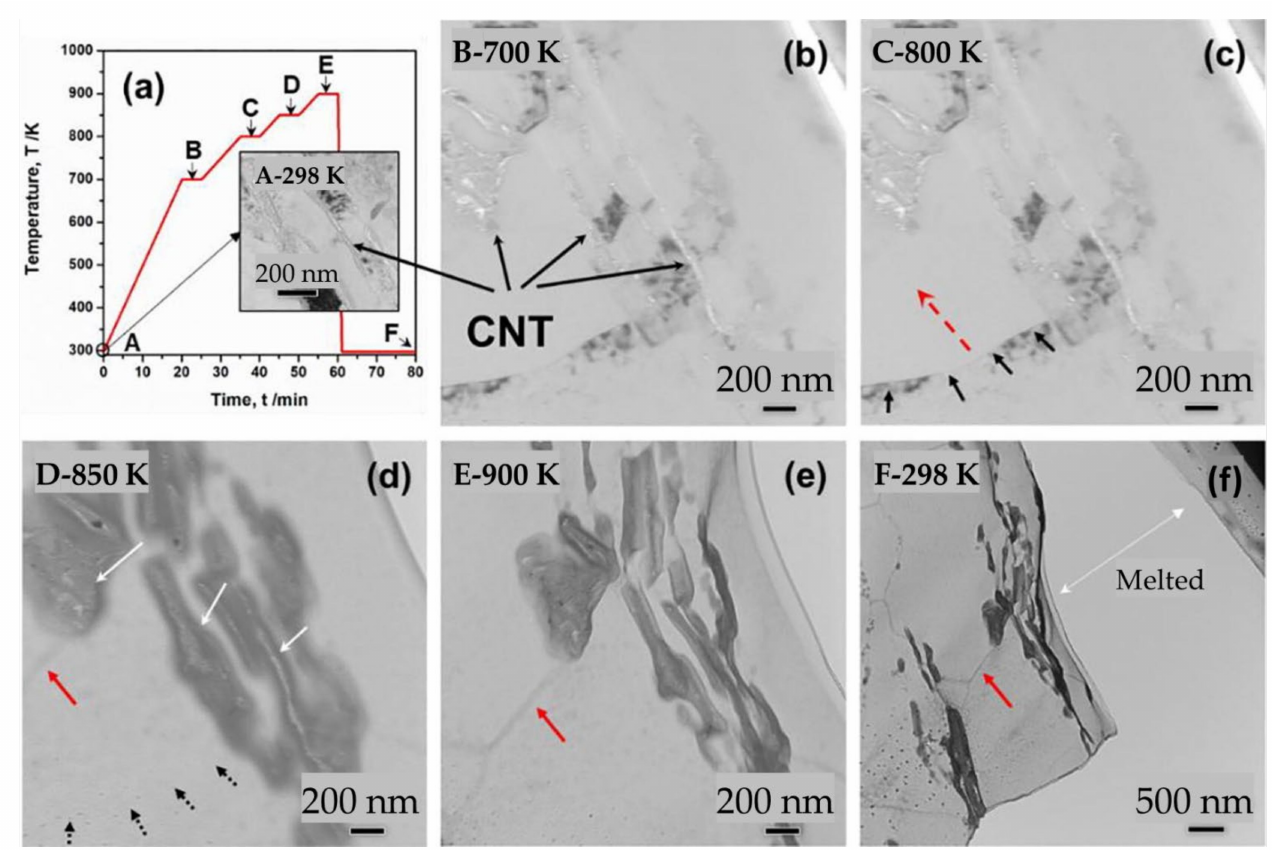
Figure 21. In situ TEM observation of Al-CNT composites at different temperatures: ( a ) temperature-time curve; ( b – f ) recorded TEM images during the stages in ( a ) as marked by corresponding capital letters. Adapted from [105] with permission from Elsevier,